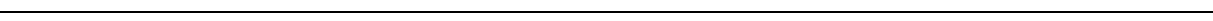
Fig. 2 US9 reduces mitochondrial MAVS by disrupting mitochondrial membrane potential. a US9 colocalizes with endogenous MAVS. HEK293T cells transfected with HA-US9-GFP were visualized by staining with anti-MAVS antibody. The nuclei were stained with DAPI. Scale bars, 10 μ m. b US9 interacts with endogenous MAVS. HEK293T cells were transfected with HA-US9-GFP followed by poly(I:C) (10 μ g ml − 1 ) for 12 h. These cells were lysed and subjected to immunoprecipitation with anti-HA antibody prior to immunoblot analysis with the indicated antibodies. c US9 dissipates Δψ m and alters mitochondrial structure. HeLa cells expressing control vector (pEGFP-N3), HA-US9-GFP, or both HA-US9-GFP and MAVS-Flag were incubated with MitoTracker Orange CMTMRos and immunostained with anti-Flag antibody, followed by AlexaFluor 350-conjugated antibody (blue). Boxed images are highlighted examples. Arrowheads or arrows indicate loss of Δψ m . Scale bars, 10 μ m. d US9 increases damaged mitochondria with loss of Δψ m . HEK293T cells were transfected as indicated and were stained with MitoTracker Deep Red and MitoTracker Green for 30 min, and then FACS analysis was performed. * P < 0.005 (Student ’ s t test). e US9 associates with Tom20. Cell lysates were immunoprecipitated with anti-Tom20 antibody, and then subjected to immunoblot analysis using the indicated antibodies. f Tom70 protein level is reduced by US9. Cell lysates were subjected to immunoblot analysis with the indicated antibodies. g US9 disrupts Tom20 – Tom70 complex formation. HEK293T cells co-expressing Myc-Tom70 and HA-US9-GFP were lysed, immunoprecipitated with anti-Tom20 antibody, and then analyzed by immunoblotting with the indicated antibodies. h MAVS localization is distorted by US9. HEK293T cells expressing MAVS-Flag with control vector (pEGFP-N3) or HA-US9-GFP were immunostained with anti-Tom20 and anti- Flag antibodies, followed by AlexaFluor 568- and AlexaFluor 350-conjugated antibodies, respectively. Arrowheads indicate distorted localization of MAVS into regions that were distant from the mitochondria. Scale bars, 10 μ m. i US9 reduces mitochondrial MAVS and induces MAVS leakage into the cytosolic/ ER fraction. HEK293T cells expressing MAVS-Flag in the absence or presence of HA-US9-GFP were separated into cytosolic/ER (Cyto/ER) and mitochondrial (Mito) fractions. Immunoblot analysis was performed using the indicated antibodies. Data are representative of three independent experiments and are presented as mean ± s.d. in